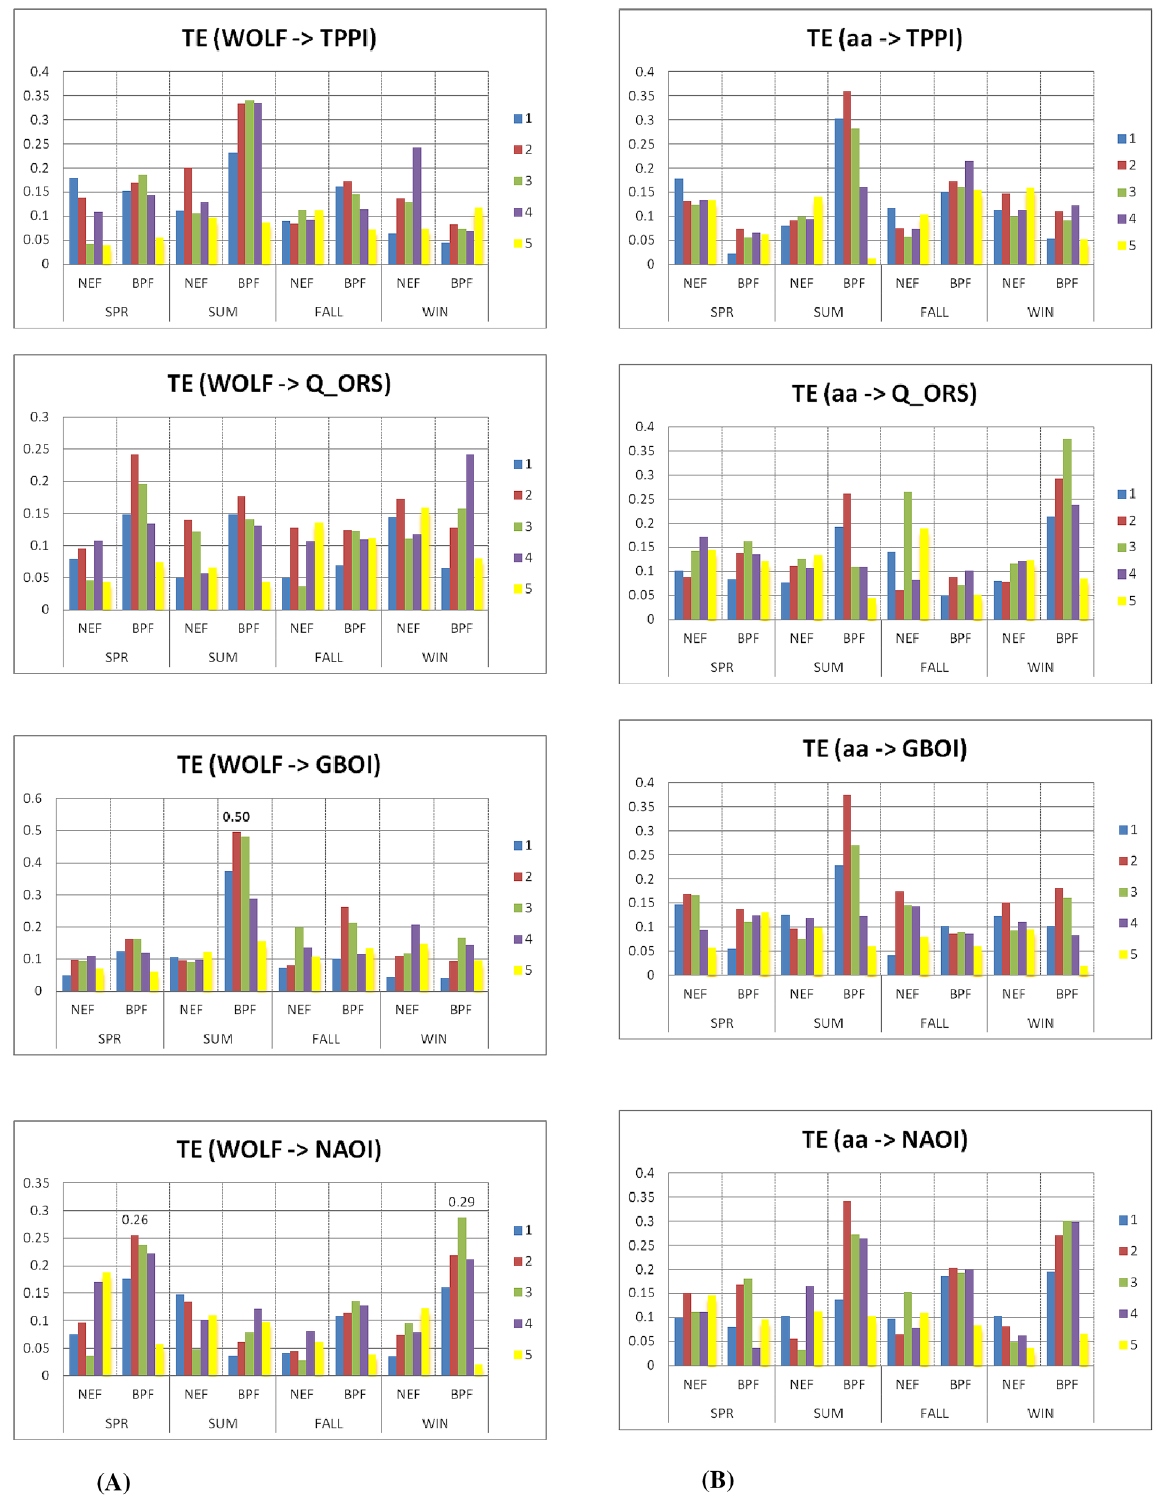
Figure 6. ( A ). The transfer entropy (TE) from Wolf number to TPPI, Q_ORS, GBOI and NAOI, with lags from 1 to 5 years, in case of unfiltered (NEF) and filtered (BPF) time series, for each season in the Period II. ( B ) The transfer entropy (TE) from aa geomagnetic index to TPPI, Q_ORS, GBOI and NAOI, with lags from 1 to 5 years, in case of unfiltered (NEF) and filtered (BPF) time series, for each season in the Period